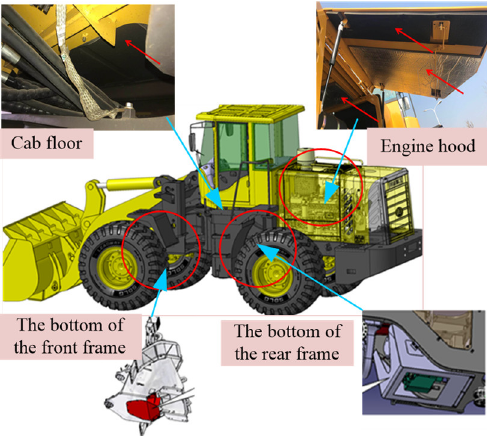
Figure 4. Pasting sponge to reduce noise.